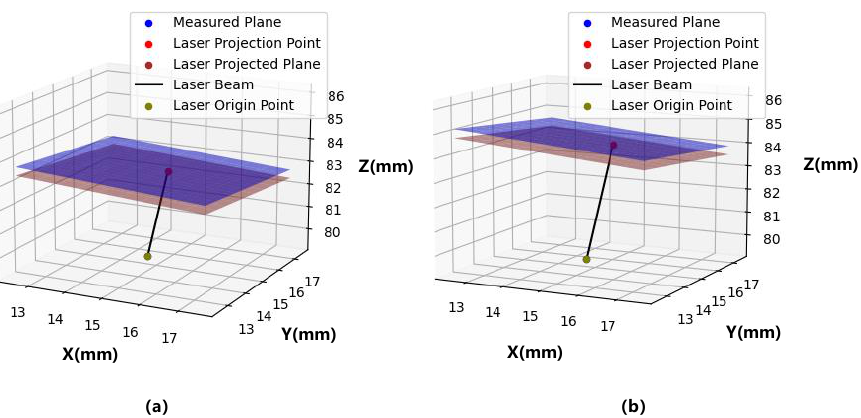
Figure 3. Visualization of the random generations ( a , b ) in a Cartesian coordinate system (axes are measured in